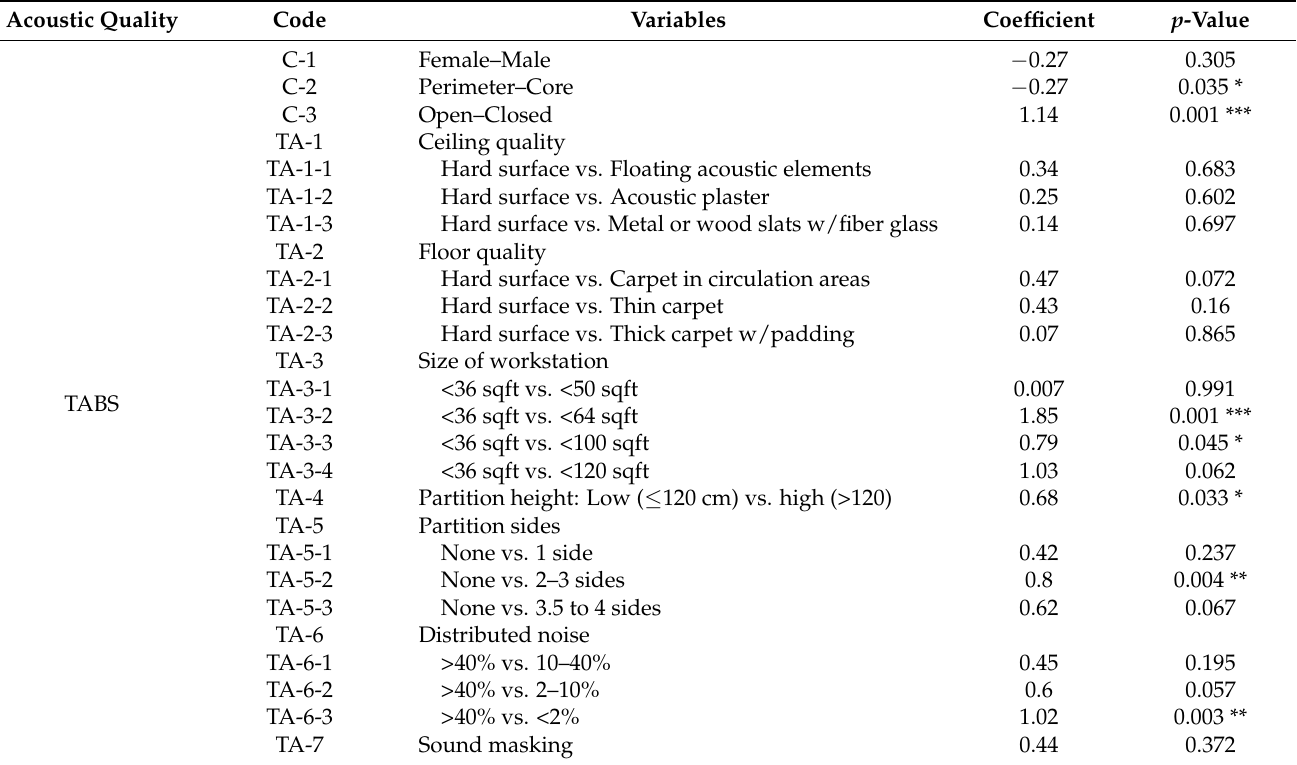
Table 8. Correlation analysis between TABS and COPE satisfaction with background noise ( n =